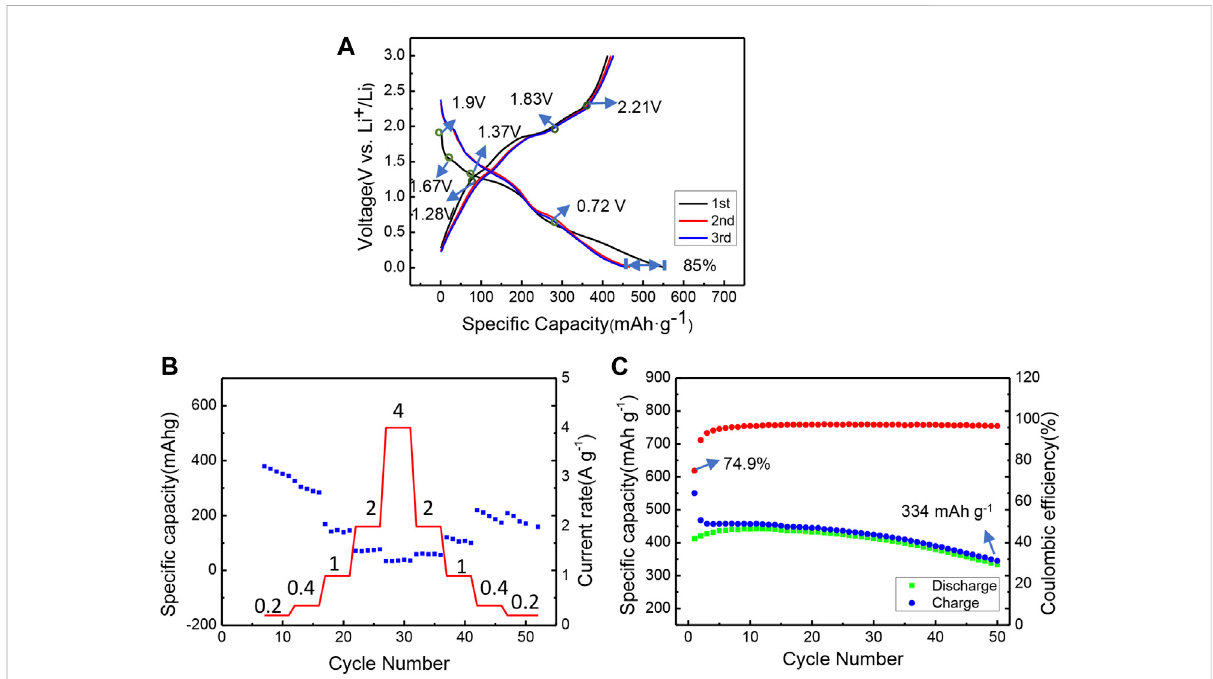
FIGURE 2 Electrochemical performance of bulk MnPSe 3 within the window 0.005 – 3 V (vs. Li + /Li). (A) The initial three discharging/charging curves of